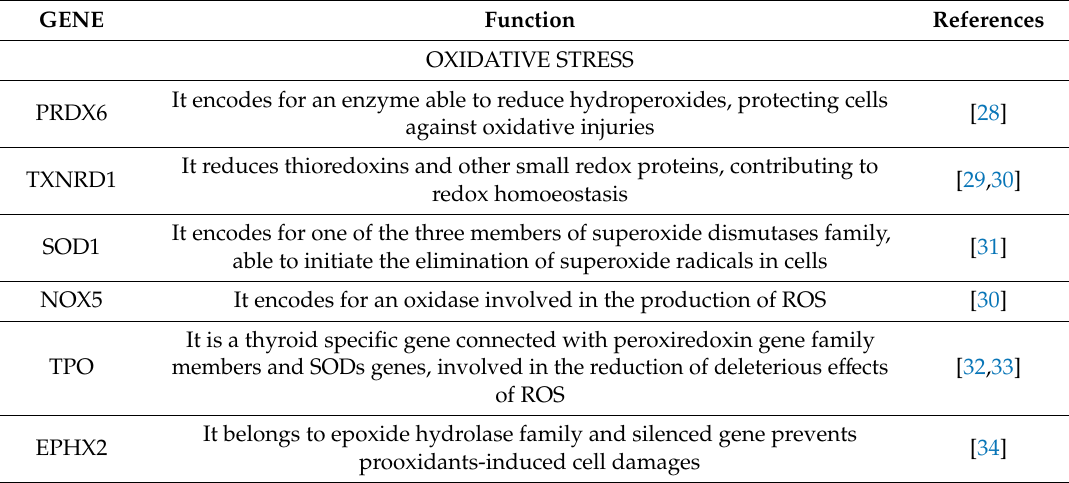
Table 1. Functional role of genes found up- or downregulated in PNT2 cells treated with DPPH. GENE